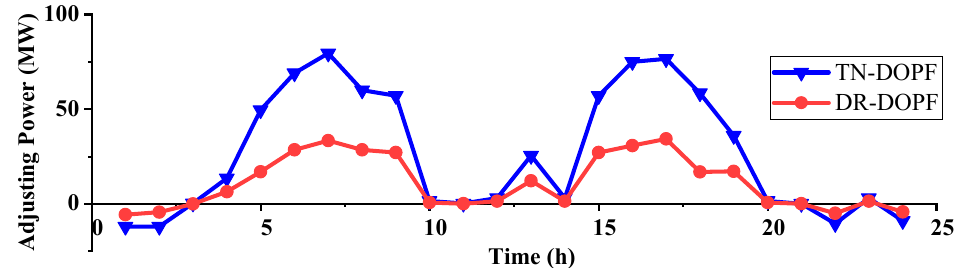
Figure 5. Adjusting power of hydropower plant 1 under two models.